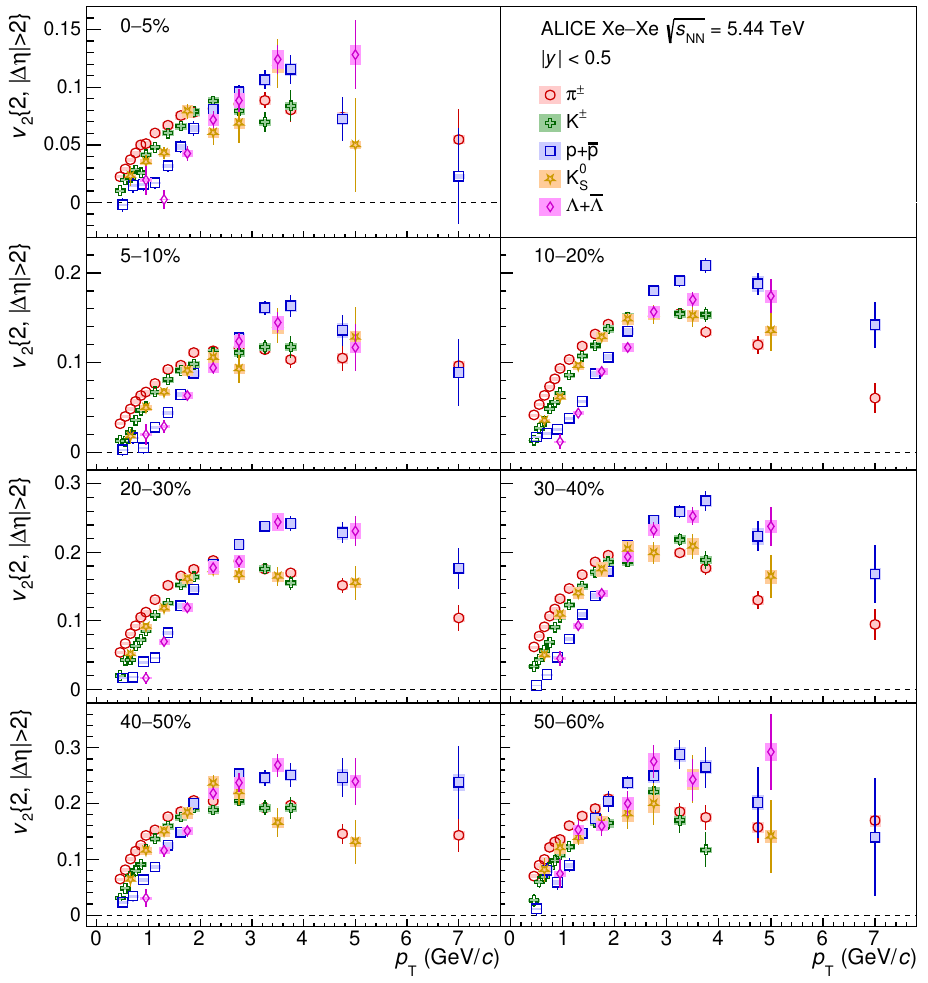
Figure 4. The p T -differential v 2 of π ± , K ± , p+ p , K 0 (boxes) denote statistical (systematic) uncertainties.